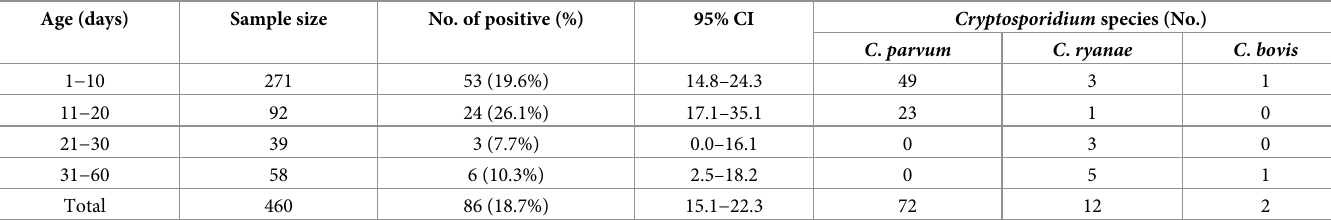
Table 1. Prevalence and distribution of Cryptosporidium species according to age group in pre-weaned calves.